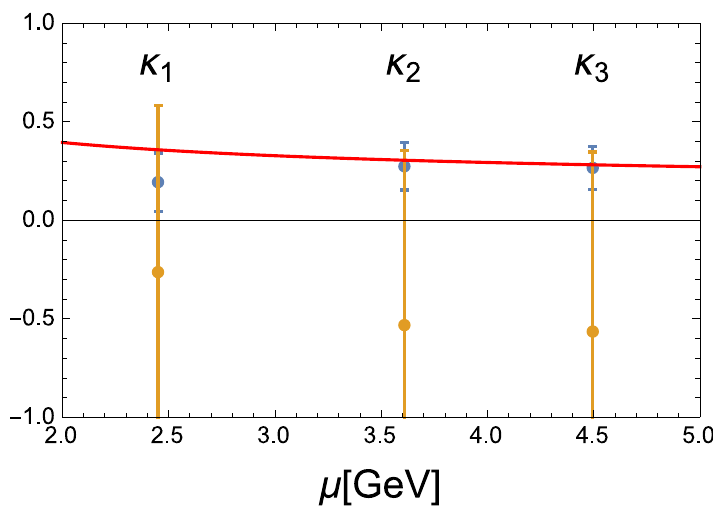
Figure 10 . Determined values of (cid:20) . Blue (orange) data represent (cid:20) i;d =1 ( (cid:20) i;d =2 ). Red curve represents the running of C F (cid:11) s ( (cid:22) 2 ) assuming (cid:3) for